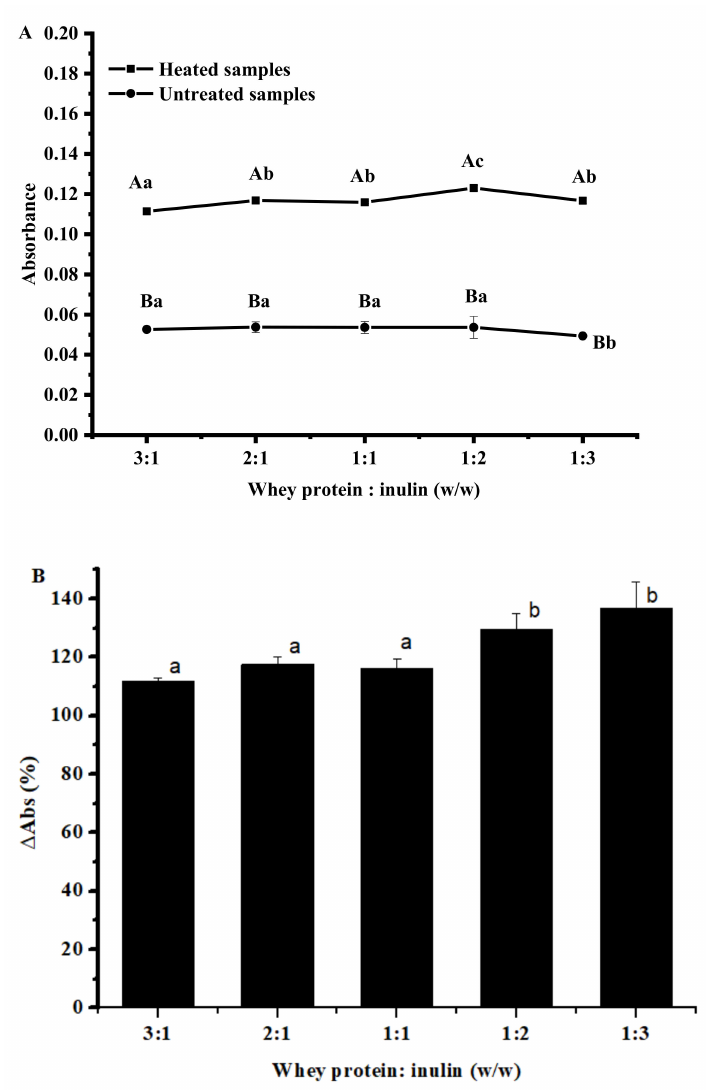
Figure 1. Browning intensity of heated and untreated whey protein and inulin mixtures ( A ) and changes in browning intensity of whey protein and inulin after heating ( B ). Di ff erent lowercase letters denote significant di ff erence between samples at di ff erent ratios; Di ff erent uppercase letters denote significant di ff erence between untreated and dry-heated samples at same whey protein and inulin ratio. Error bars are ± SD of the